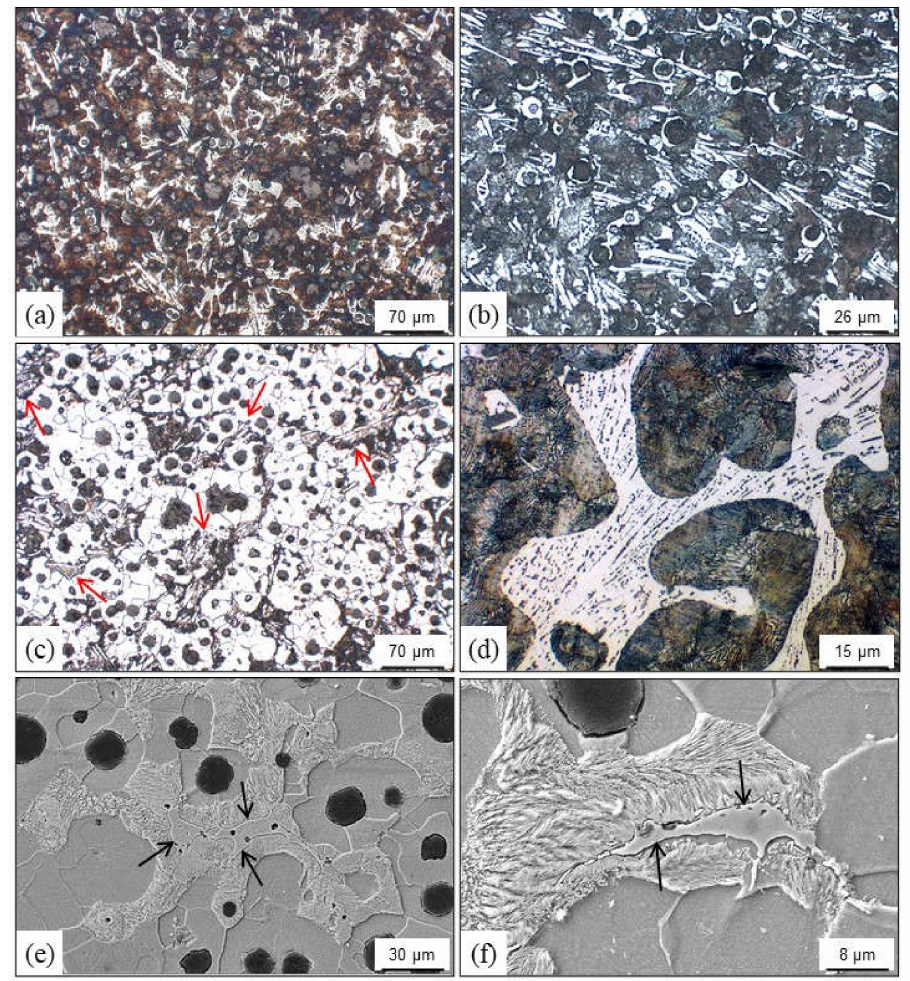
Figure 88. Iron carbides found in ductile iron pearlitic ( a , b ) and mostly ferritic ( c ) castings. Steadite (Fe 3 P) found in a grey iron casting ( d ). SEM images which show carbides embedded in the last solidification areas together with pearlite ( e , f ).